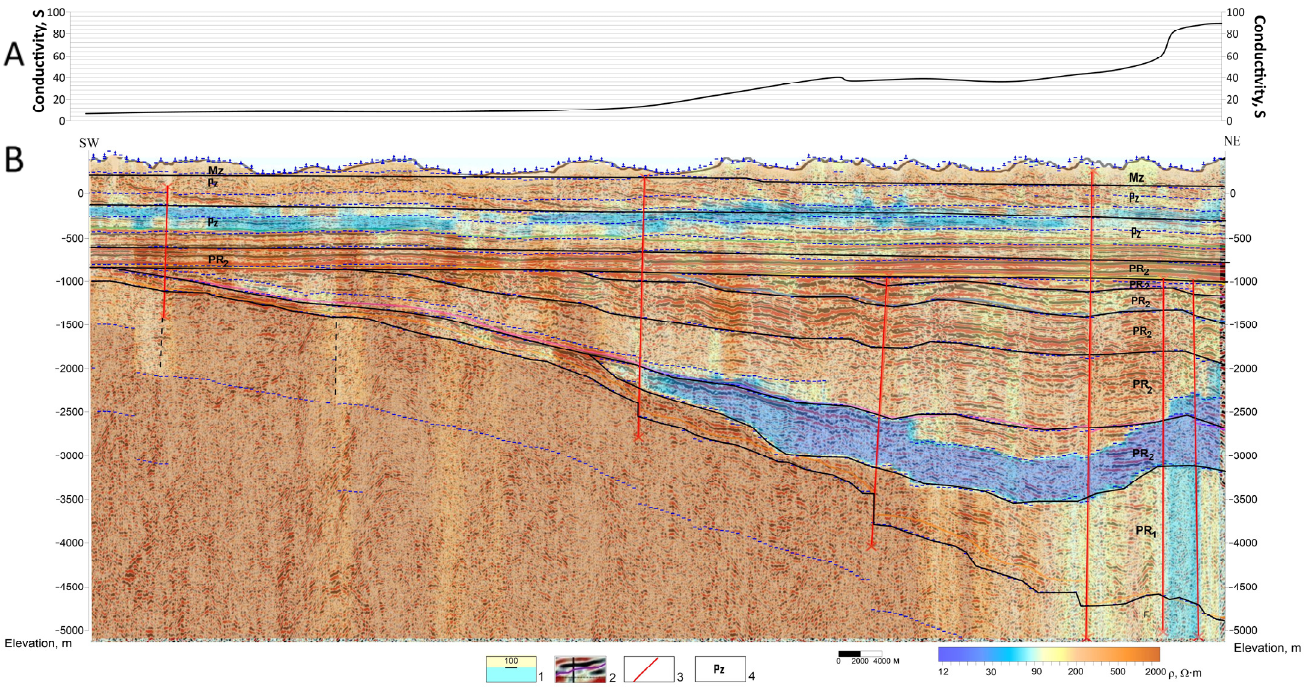
Figure 1. Total conductivity pattern from 2D TEM data ( A ) and combined seismic-resistivity cross-section of Aldan-Maya Basin from 2D TEM and 2D CMP data ( B ). 1 = resistivity layers and their resistivity in Ohm·m; 2 = seismic time section; 3 = faults inferred from seismic data; 4 = wells.